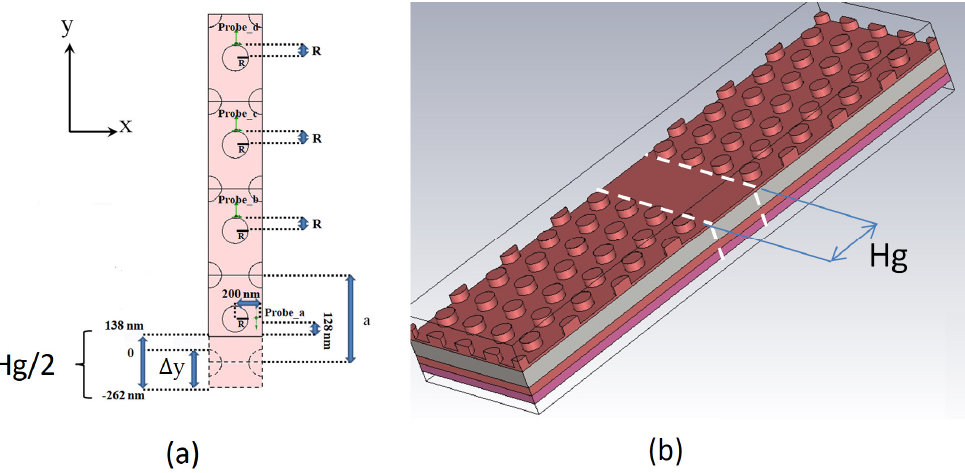
Figure 2. PPhC with extended defect: ( a ) Top view with definition of geometric parameters and positions of the E—field probes. ( b ) Extended 3D model.